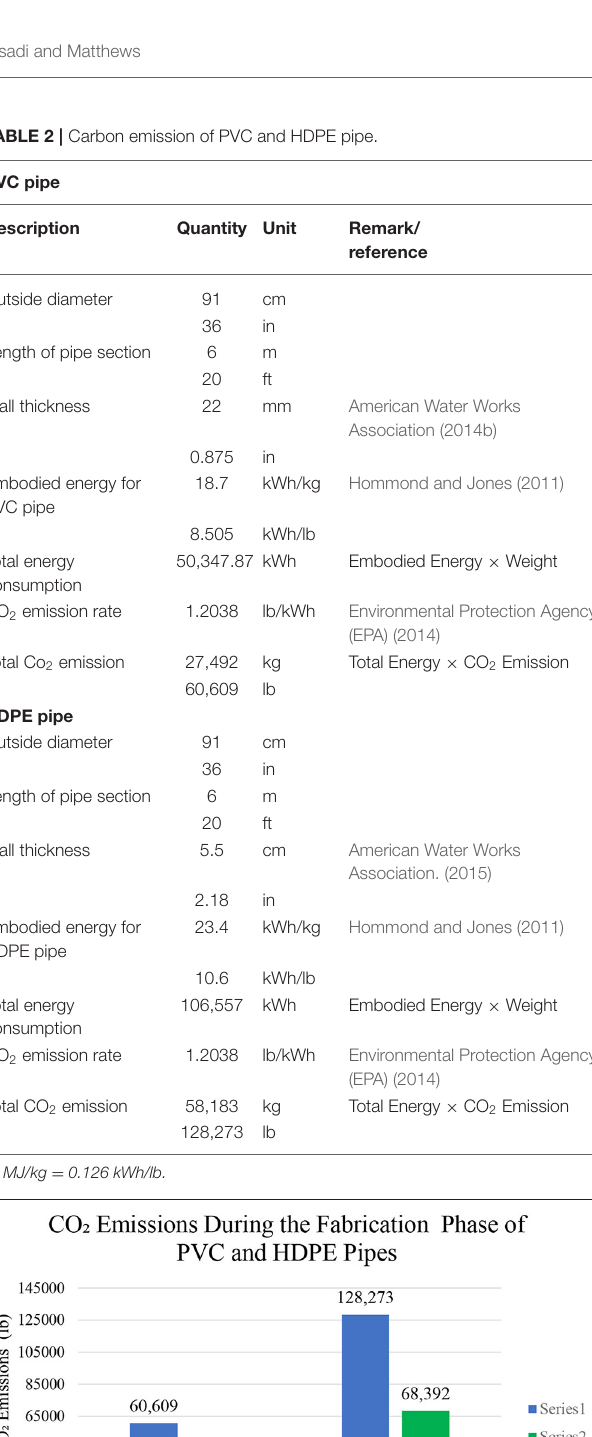
FIGURE 4 | Shown the difference in carbon emissions through the fabrication phase of pipe materials before and after the optimizing.